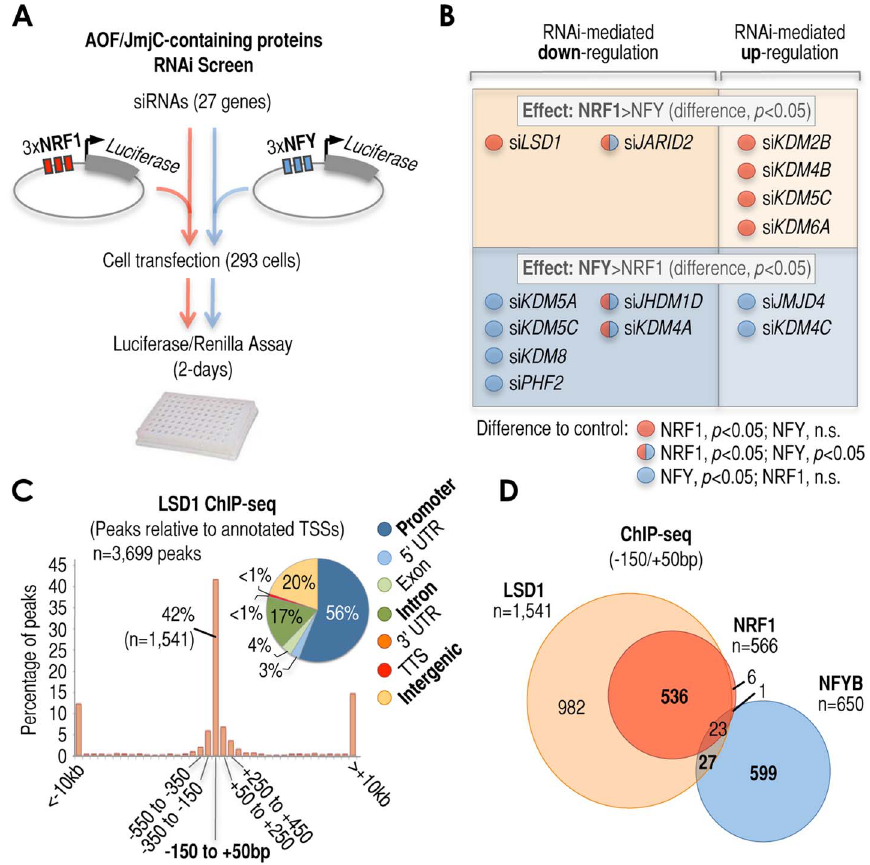
Figure 2. Cardinal motifs dictate patterns of transcriptional regulatory activities. ( A ) Schematic overview of the siRNA-based screen to identify lysine demethylase (KDM) activities that may act selectively via NRF1 or NFYB motifs. KDMs belong to two gene families: the family of amine oxidase flavin (AOF)-containing domain proteins, and the family of Jumonji C (JmjC)-containing proteins. HEK293T cells were transfected with a vector expressing the luciferase gene under control of three multimerized copies of NRF1 (3 6 NRF1, left side of the scheme) or three multimerized copies of NFY (3 6 NFY, right side of the scheme). Luciferase levels were tested after independent treatment with n=27 different KDM siRNAs, plus controls. ( B ) Summary of siRNA-mediated effects that showed selectivity for 3 6 NRF1 or 3 6 NFY motifs in our screen. A total of n=14 out of n=27 siRNA treatments induced selective effects: n=6 were selective of the presence of 3 6 NRF1 (top), and n=8 were selective of the presence of 3 6 NFY (bottom). Of these n=14 siRNA treatments, furthermore, n=8 induced down-regulation of the reported gene (left), and n=6 induced its up- regulation (right). Selectivity for 3 6 NRF1 or 3 6 NFY motifs was established by the direct comparison of siRNA-mediated effects induced by the same siRNA treatment on 3 6 NRF1- or 3 6 NFY-luciferase (( p , 0.05; last row in Figure S3A ). In n=11 out of the n=14 treatments (red circles if selective of 3 6 NRF1, or blue circles if selective of 3 6 NFY), the difference between the specific KDM and control (scrambled) siRNA-mediated effect was also statistically significant ( p , 0.05; first and second rows in Figure S3A ). In the other n=3 out of the n=14 selective siRNA treatments (red-and-blue circles), the difference with respect to control siRNA was statistically significant for both 3 6 NRF1- and 3 6 NFY-regulated units, although statistically significant also when compared between them ( p , 0.05; last row in Figure S3A ). ( C ) Positional binding analysis of LSD1 in MCF7 cells (as in Figure 1C ), and genomic localization of LSD1 ChIP-seq peaks with respect to the genome annotation (pie chart). The numbers included in the pie chart refer to the fraction of LSD1 peaks associated with each annotated region. ( D ) Venn diagram depicting the overlap of LSD1 (orange), NRF1 (red), and NFYB (blue) ChIP-seq peaks at 2 150/ + 50 bp regions in MCF7 cells. We considered as ‘overlap’ the coincidence of NRF1, NFYB, and/or LSD1 peaks in the same 2 150/ + 50 bp